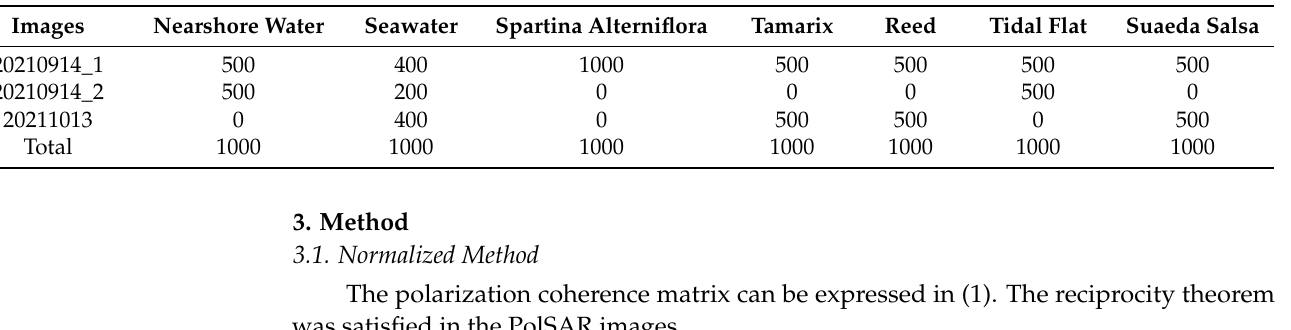
Figure 2. UAV images of ground objects. ( a ) Nearshore water, ( b ) Seawater, ( c ) Spartina alterniflora, ( d ) Suaeda salsa, ( e ) Tamarix, ( f ) Reed, ( g ) Tidal flat. Table 2. Samples